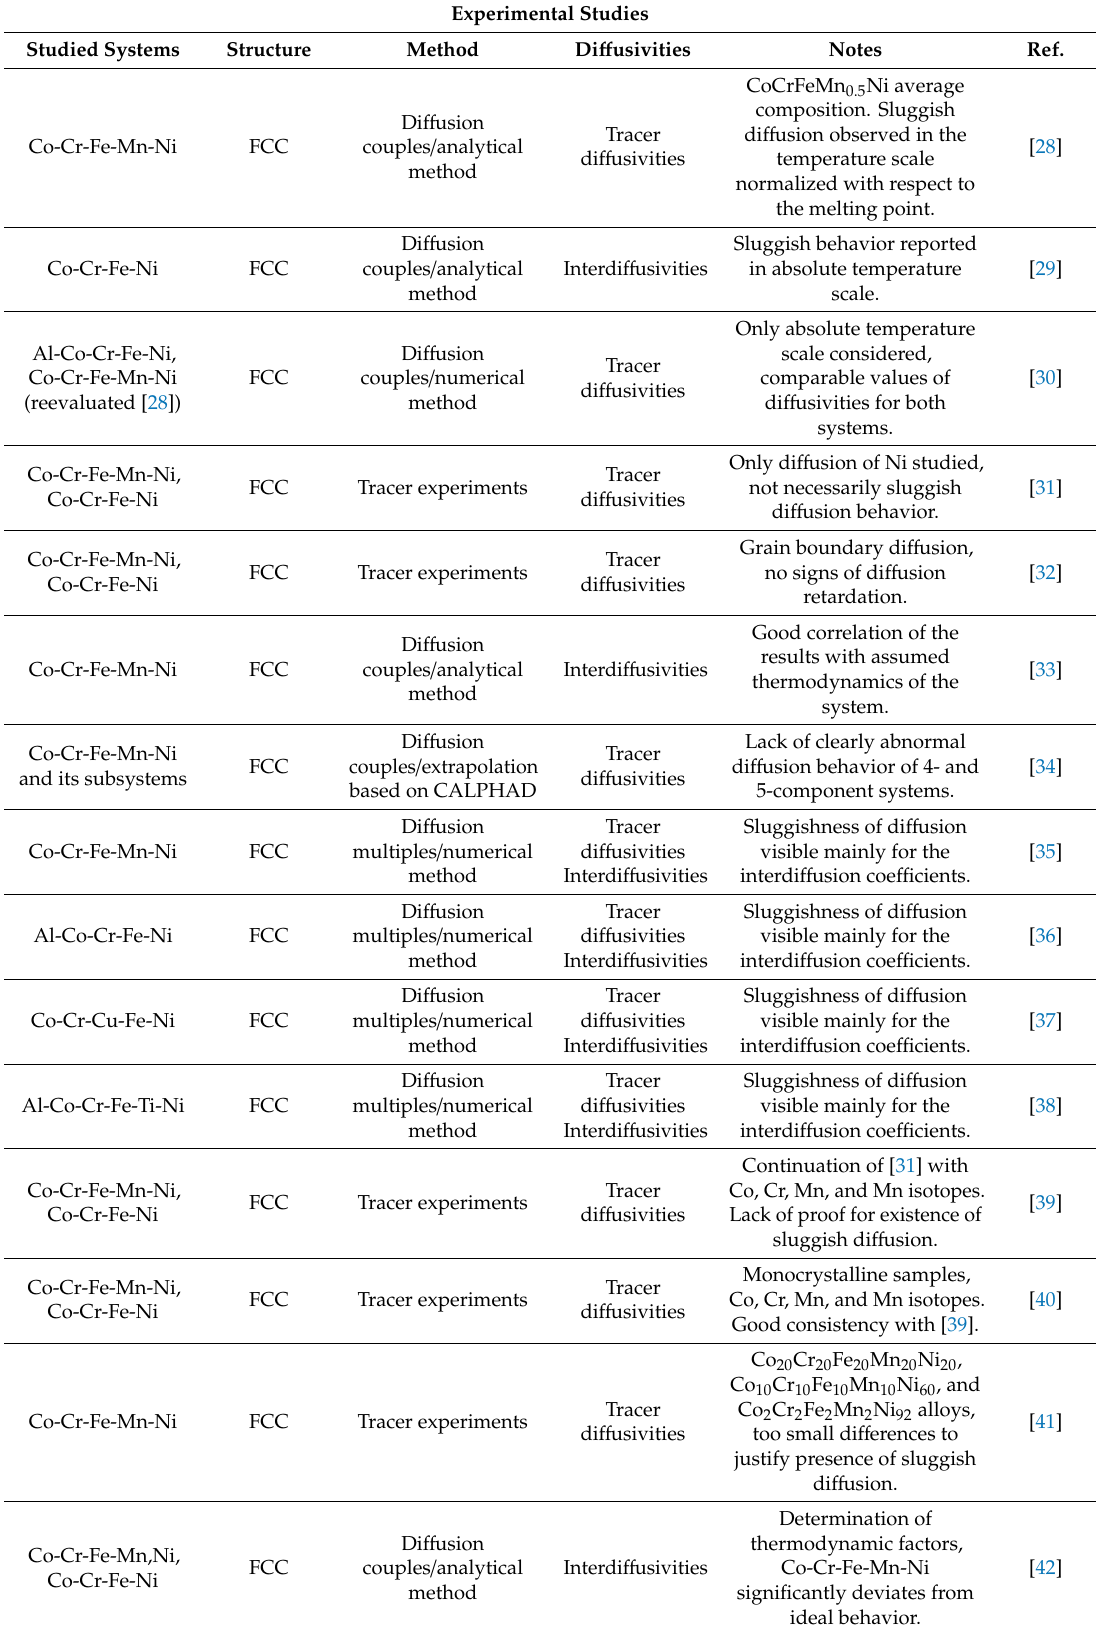
Table 1. Summary of the published articles on the subject of di ff usion in high entropy